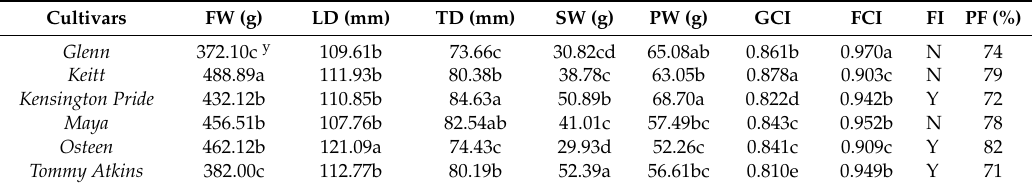
Table 2. Pomological aspects of the six mango cultivars in trial. Fruit weight (FW); longitudinal diameter (LD); transversal diameter (TD); seed weight (SW); peel weight (PW); ground colour